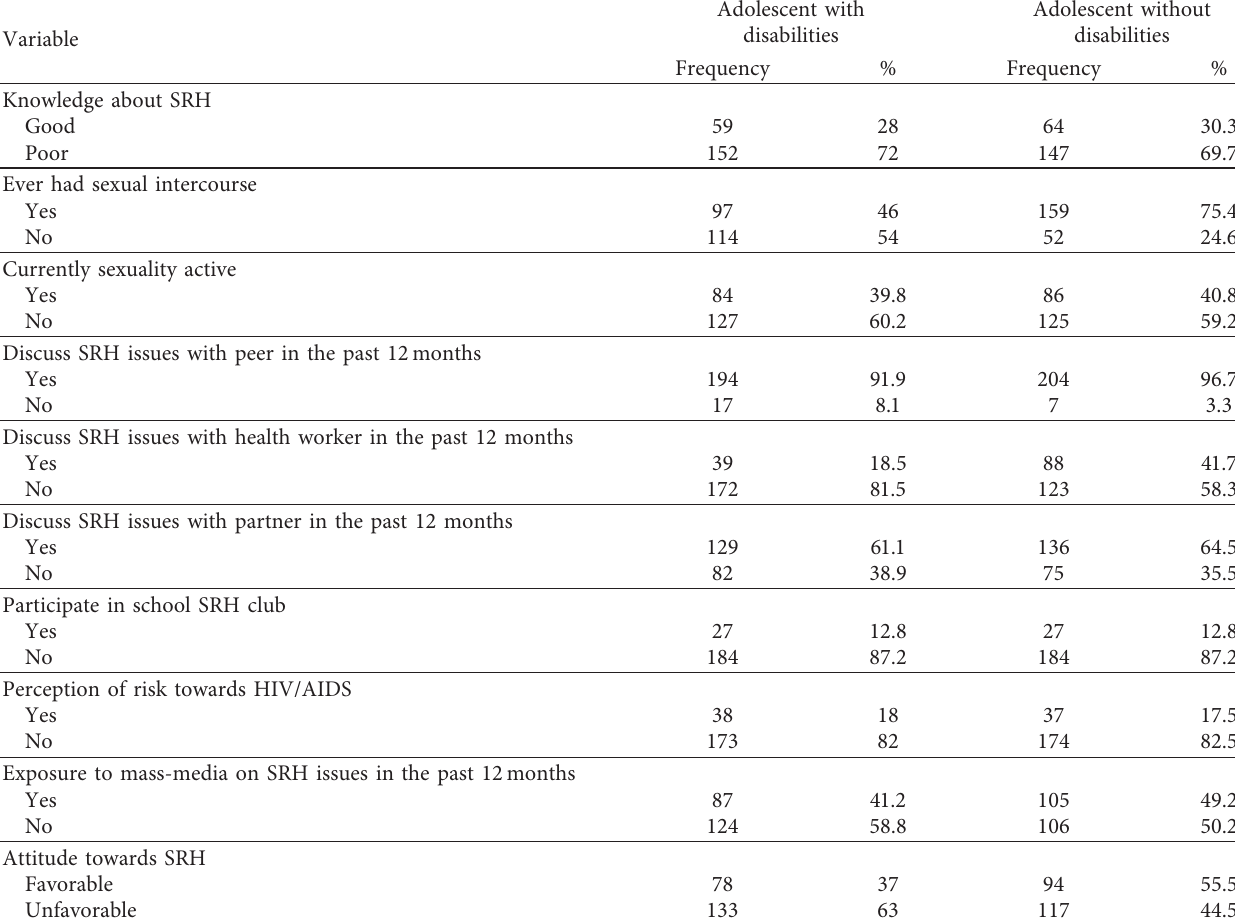
Table 2: Frequency distribution of adolescents by their individual-level characteristics in Arba Minch town school, 2019/2020.